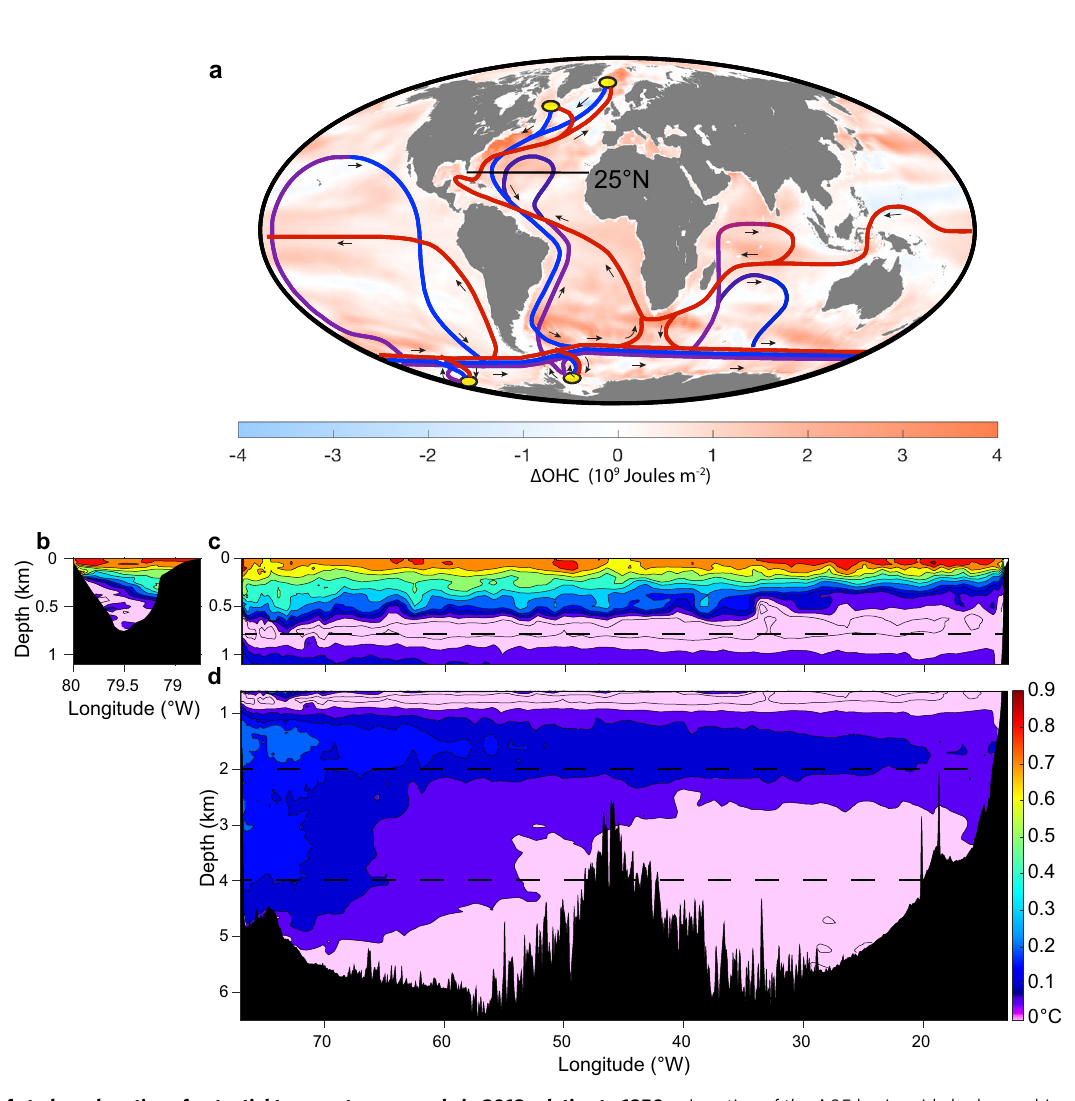
Fig. 1 Area of study and section of potential temperature anomaly in 2018 relative to 1850. a Location of the A05 basin-wide hydrographic section along 25°N (black line) superimposed on the spatial map of annual mean 0 – 2000 m Δ OHC (10 9 Joules m − 2 ) in 2019 relative to a 1981 – 2010 baseline (IAP data 7, 87 ). The schematic of the meridional overturning circulation (MOC) shows surface currents carrying heat towards the poles (red line) and the North Atlantic Deep Water and Antarctic Bottom Water formation sites (yellow dots) where surface waters lose buoyancy, downwell, and subsequently feed the deep (blue) and bottom (purple) return fl ows of the MOC, adapted from ref. 88 . b – d Vertical distribution of reconstructed potential temperature anomalies (°C) in 2018 relative to 1850 along A05 for ( b ) the Florida Strait, ( c ) the top 1100 m and ( d ) below 1000m of the transatlantic section. The colour scale in ( d ) applies also to ( b ) and ( c ). The dashed lines delimit the depth layers used for the section